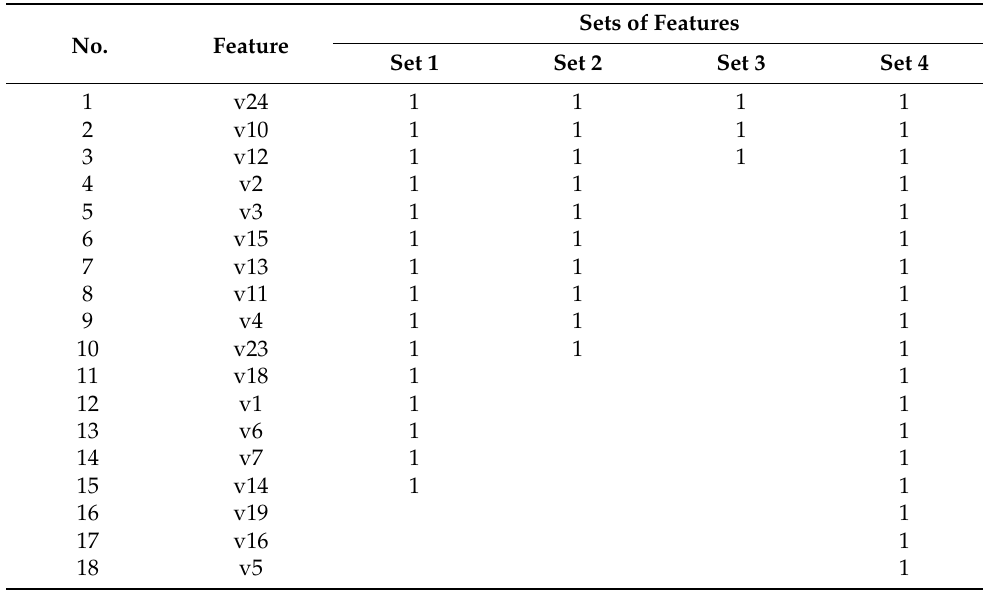
Table 3. Sets of features for analyzed predictive